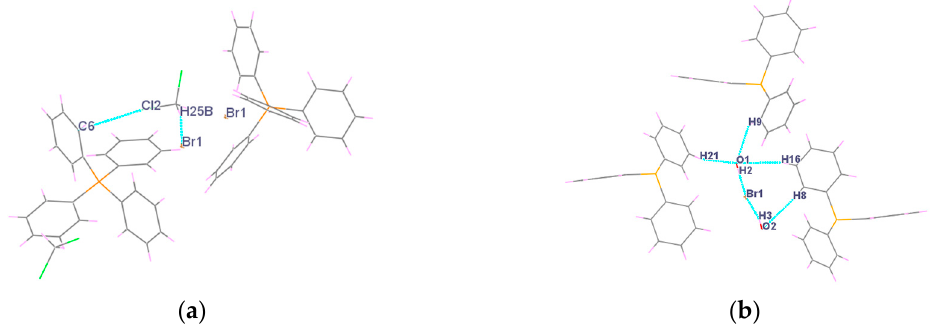
Figure 3. Short contacts between solvent and parent molecules in ( a ) TPPB (CH 2 Cl 2 ); ( b ) TPPB (2H 2 O).